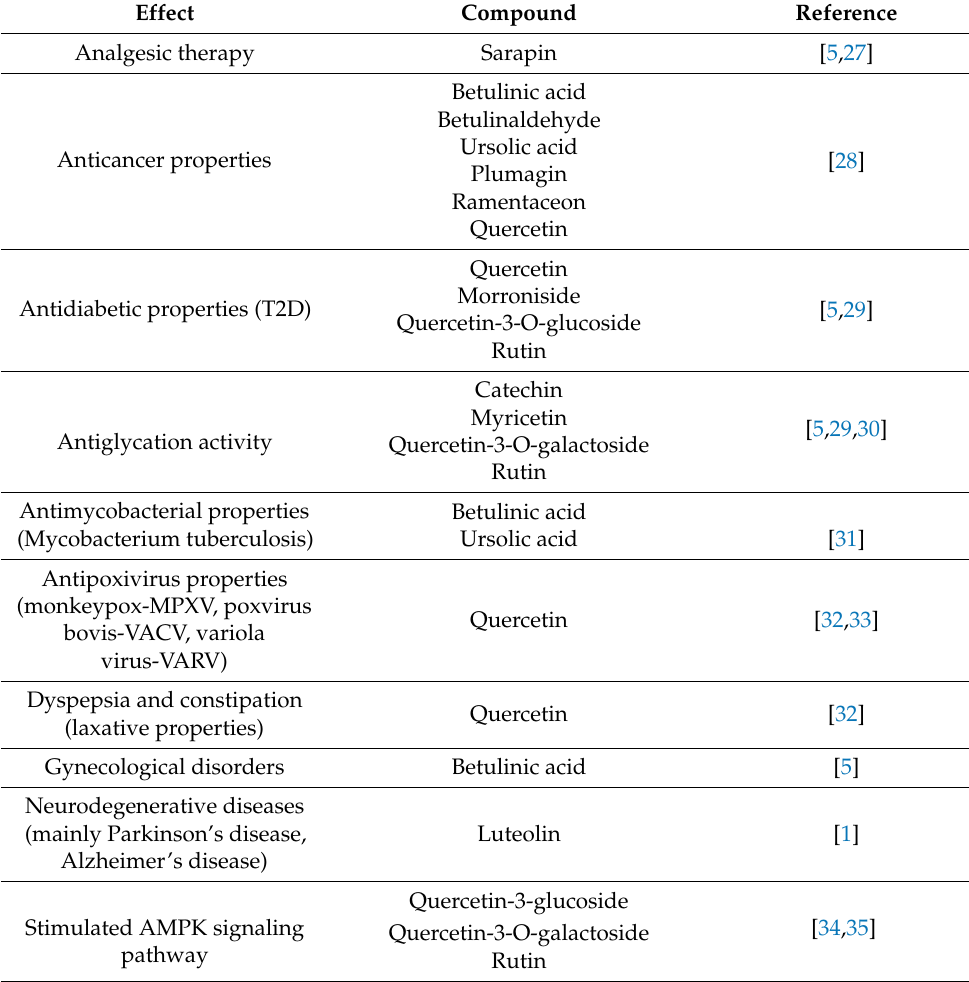
Table 3. Potential bioactive properties of compounds found in plants of the genus Sarracenia